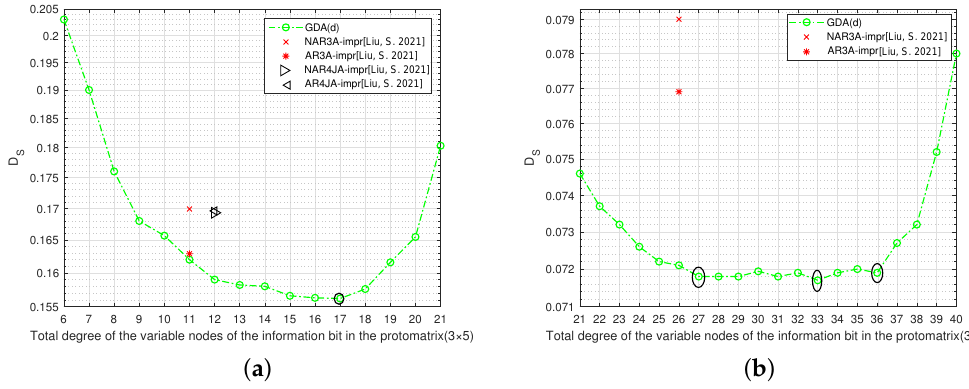
Figure 8. Compression performance of codes generated by different total degrees of the variable nodes corresponding to the information bit in the protomatrix using the GDA algorithm for noise-free channels [11]. ( a ) Code rate: 0.4 ( b ) Code rate: 0.66.